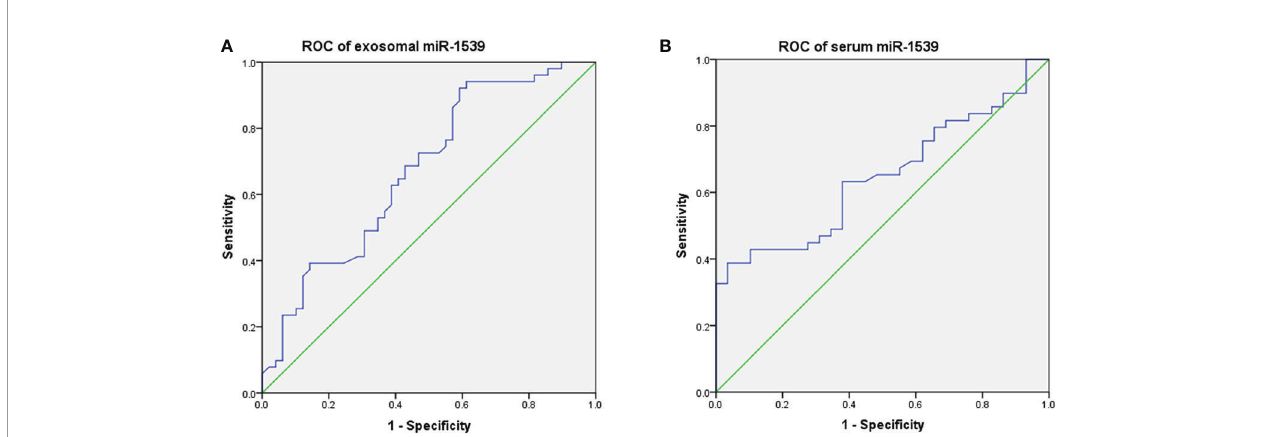
FIGURE 4 | Diagnostic values of circulating miR-1539 based on ROC curves. (A) exosomal miR-1539 between CRC and HCs. (B) serum miR-1539 in LCRC and HCs. CRC, colorectal cancer; HCs, healthy controls; LCRC, left-sided colorectal cancer. *p < 0.05.